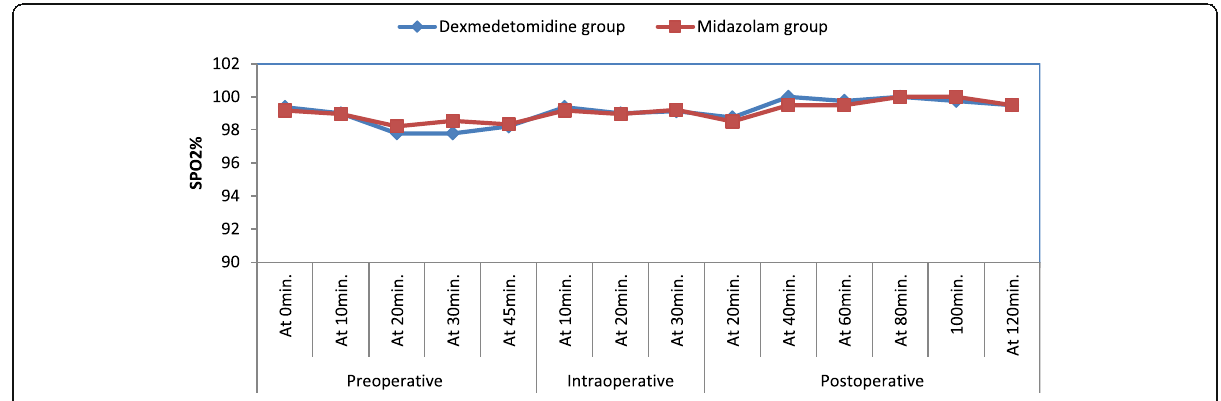
Fig. 4 Comparison between group D and group M regarding SpO 2 %. Data are presented as mean